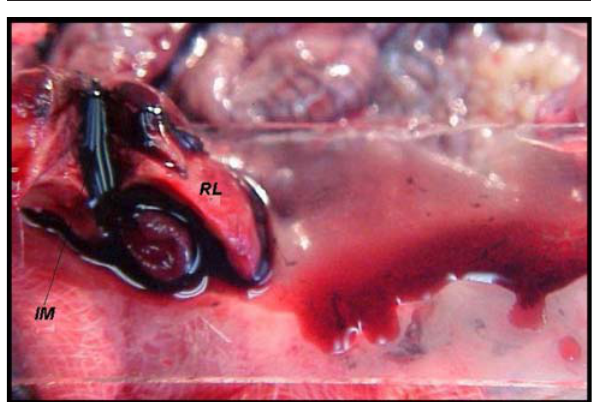
FIGURE 5 - Macroscopic aspect of the right lobe ( RL ) of the liver isolated from the hepatic hilum, longitudinally sectioned, positioned on a glass slide. The presence of blood associated with the ink marker ( IM ). Group with simultaneous HA and PVRB ligation and omental transposition at POD 90, 3x.